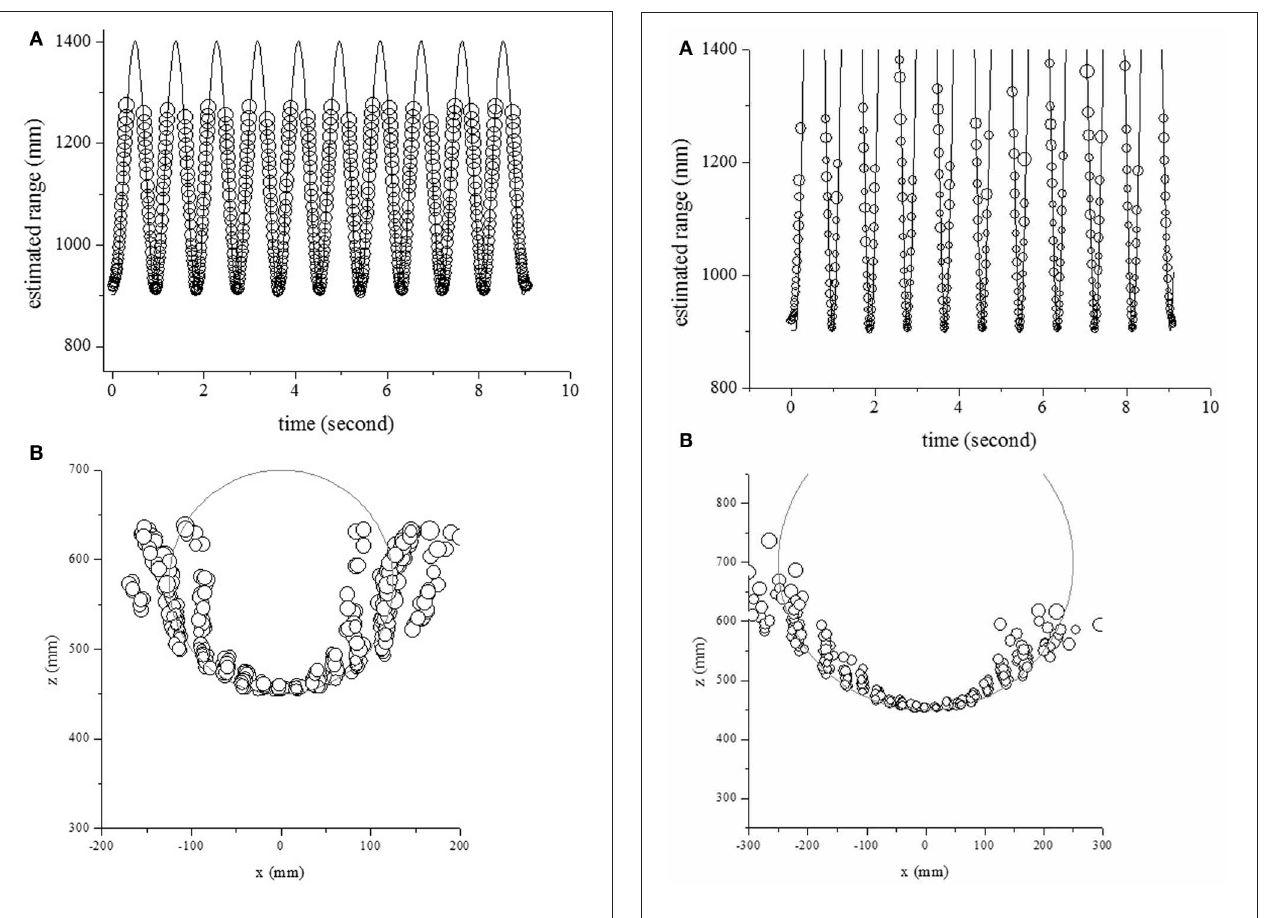
FIGURE 7 | Outputs for one object, moving side to side with a rotation radius of 125mm. (A) Estimated and actual ranges. (B) Estimated and actual positions in 2D space.